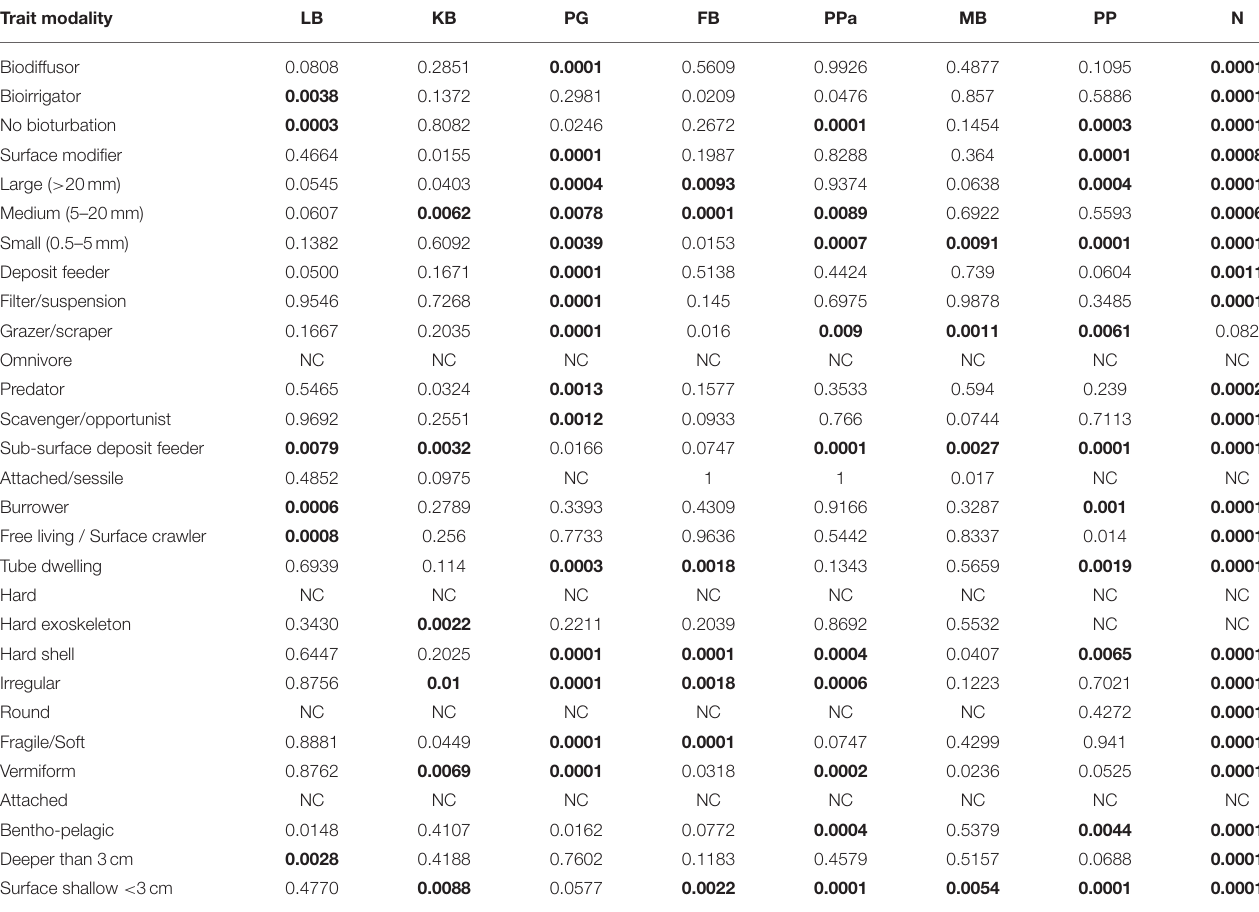
TABLE 5 | Summary of PERMANOVA Pair-wise test of CWM trait modalities comparing differences across seasons by sites. Trait